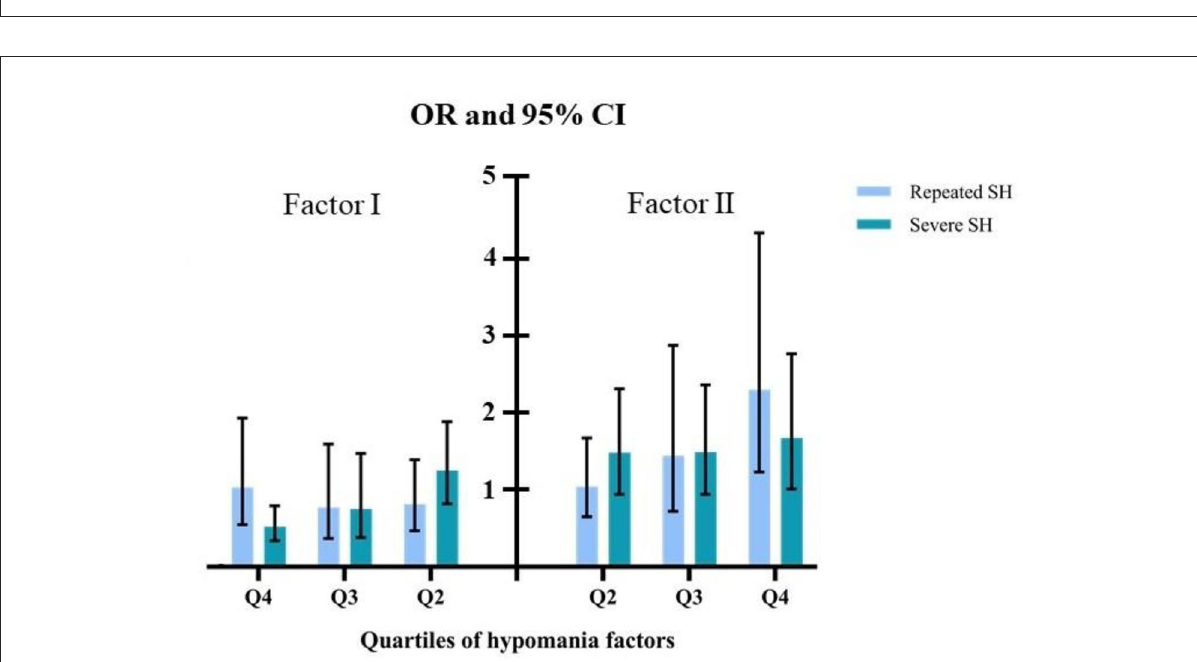
FIGURE3 Quartiles of hypomania factors with SH severity and repetition (reference: